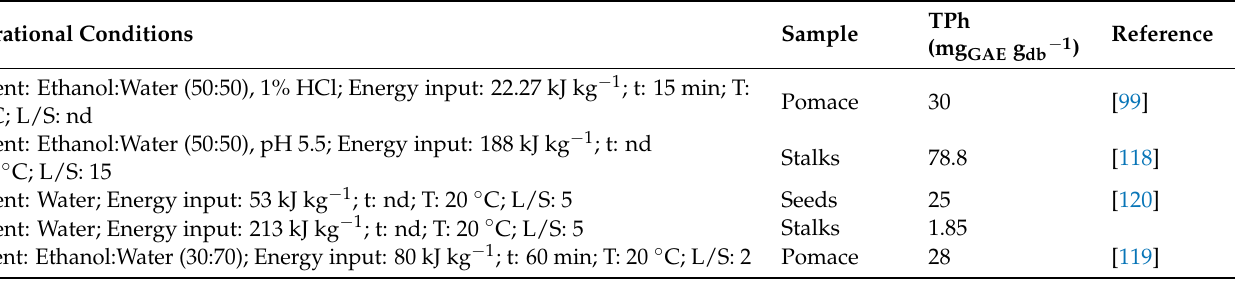
Table 11. Summary of high-voltage discharge extraction for the recovery of phenolic compounds from winery